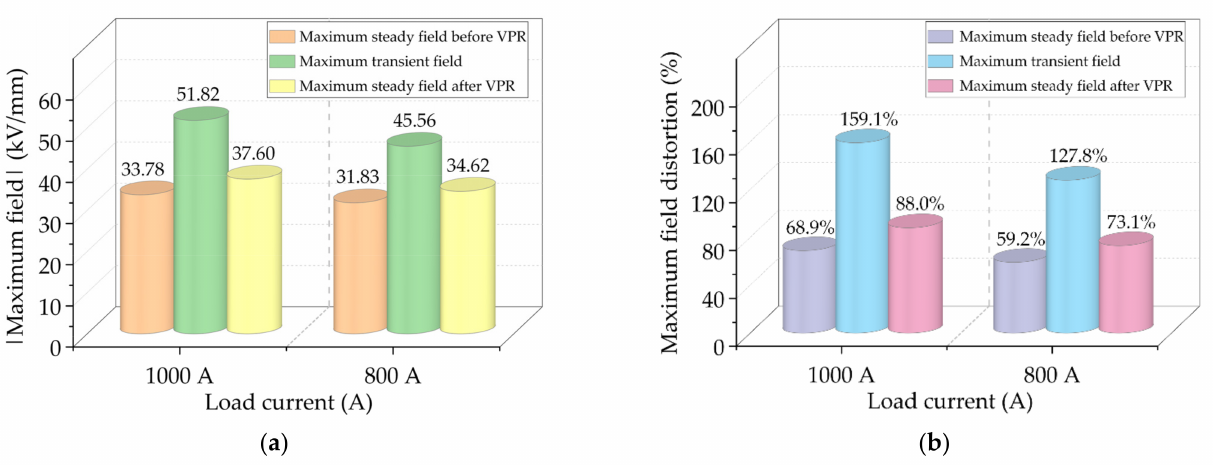
Figure 12. Absolute values of maximum transient fields and the corresponding field distortion with a PRP of 120 s, under steady and transient states: ( a ) Maximum field; ( b ) Maximum field